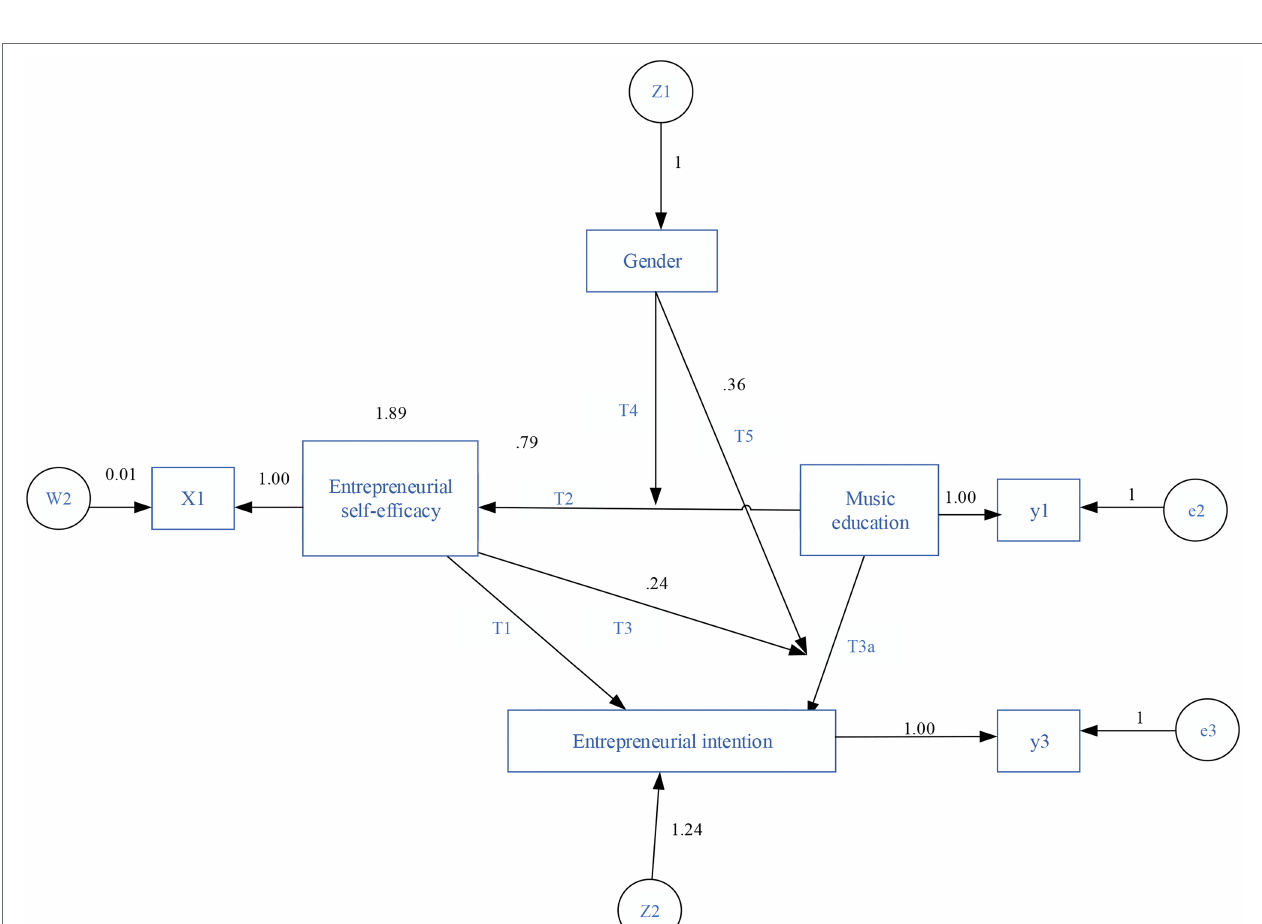
FIGURE 2 | Amos structural equation model constructed here.